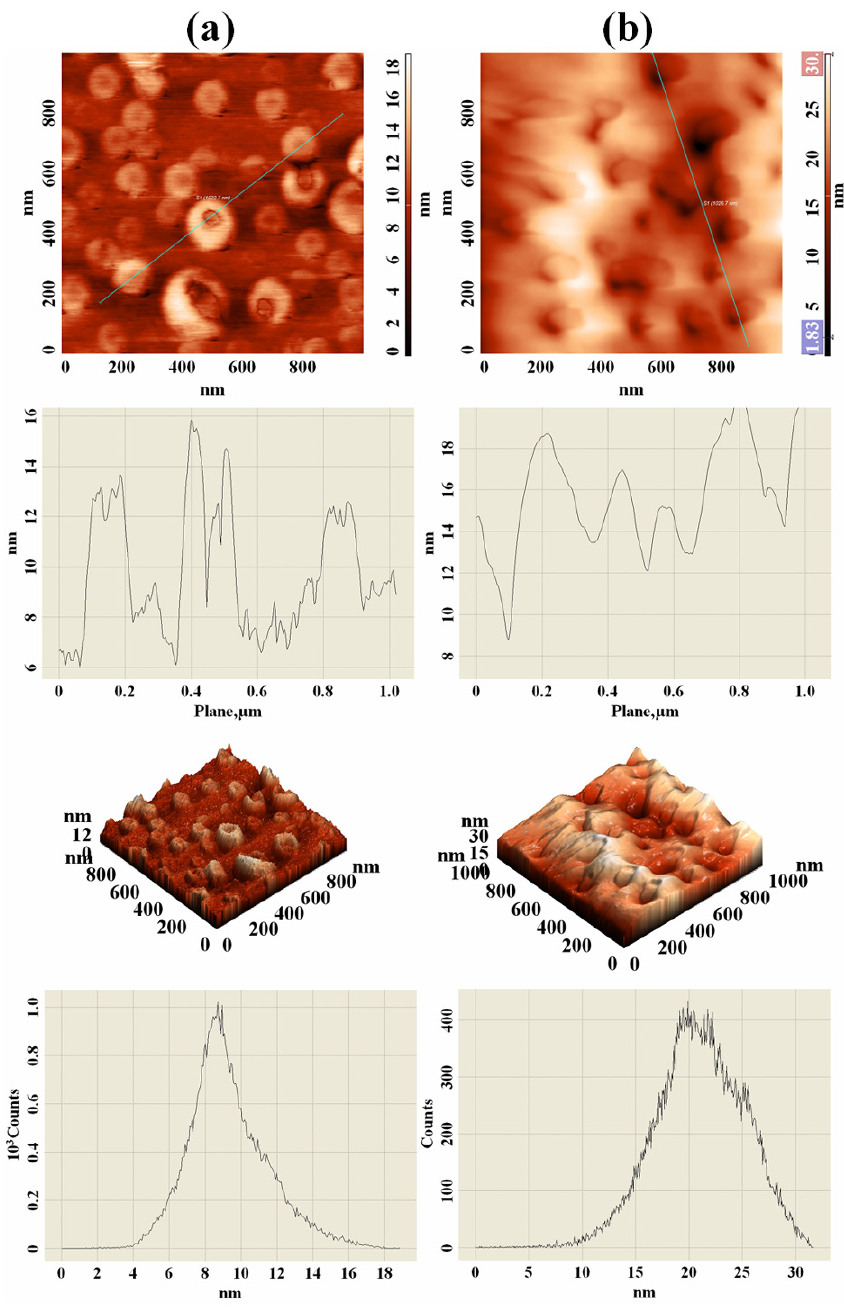
Figure 8. The AFM images of ZnO-PCEMA- b -PEGMA-Br-2 thin film before (a) and after (b) UV